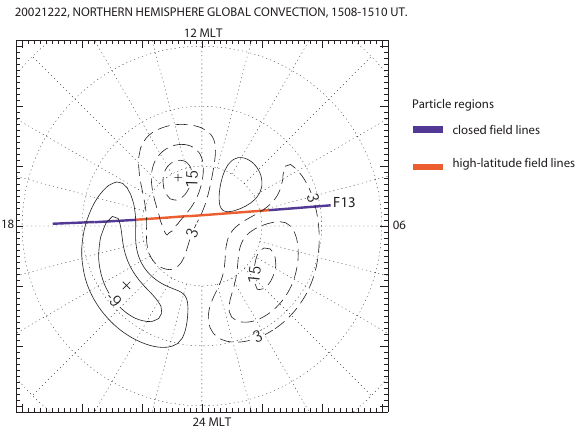
Fig. 15. Polar-plot of the DMSP F13 spacecraft track across the Northern Hemisphere polar region from 15:06 to 15:20 UT. The track is presented as a function of MLAT and MLT, with local noon being located at the top of the plot. The track of the spacecraft is coloured blue equatorward of the open-closed field line boundary, and red poleward of the open-closed field line boundary. Overlaid on the plot are the potential contours observed by the map-potential technique from 15:08 to 15:10